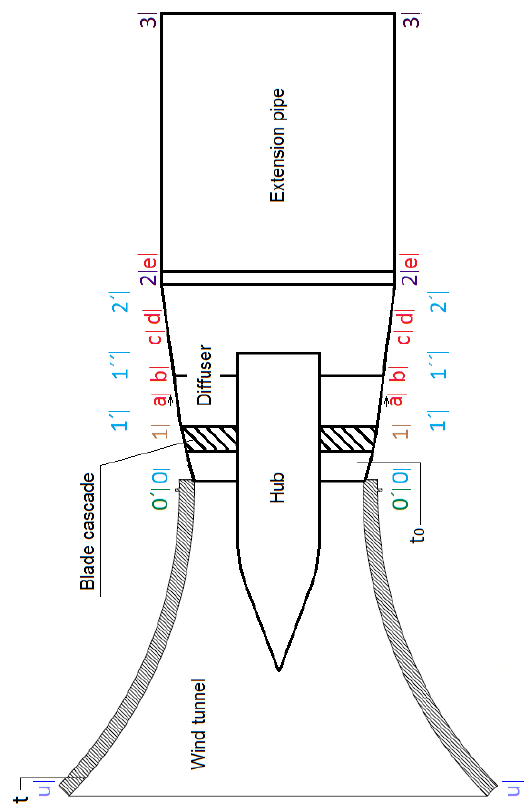
Fig. 4. Scheme with marked